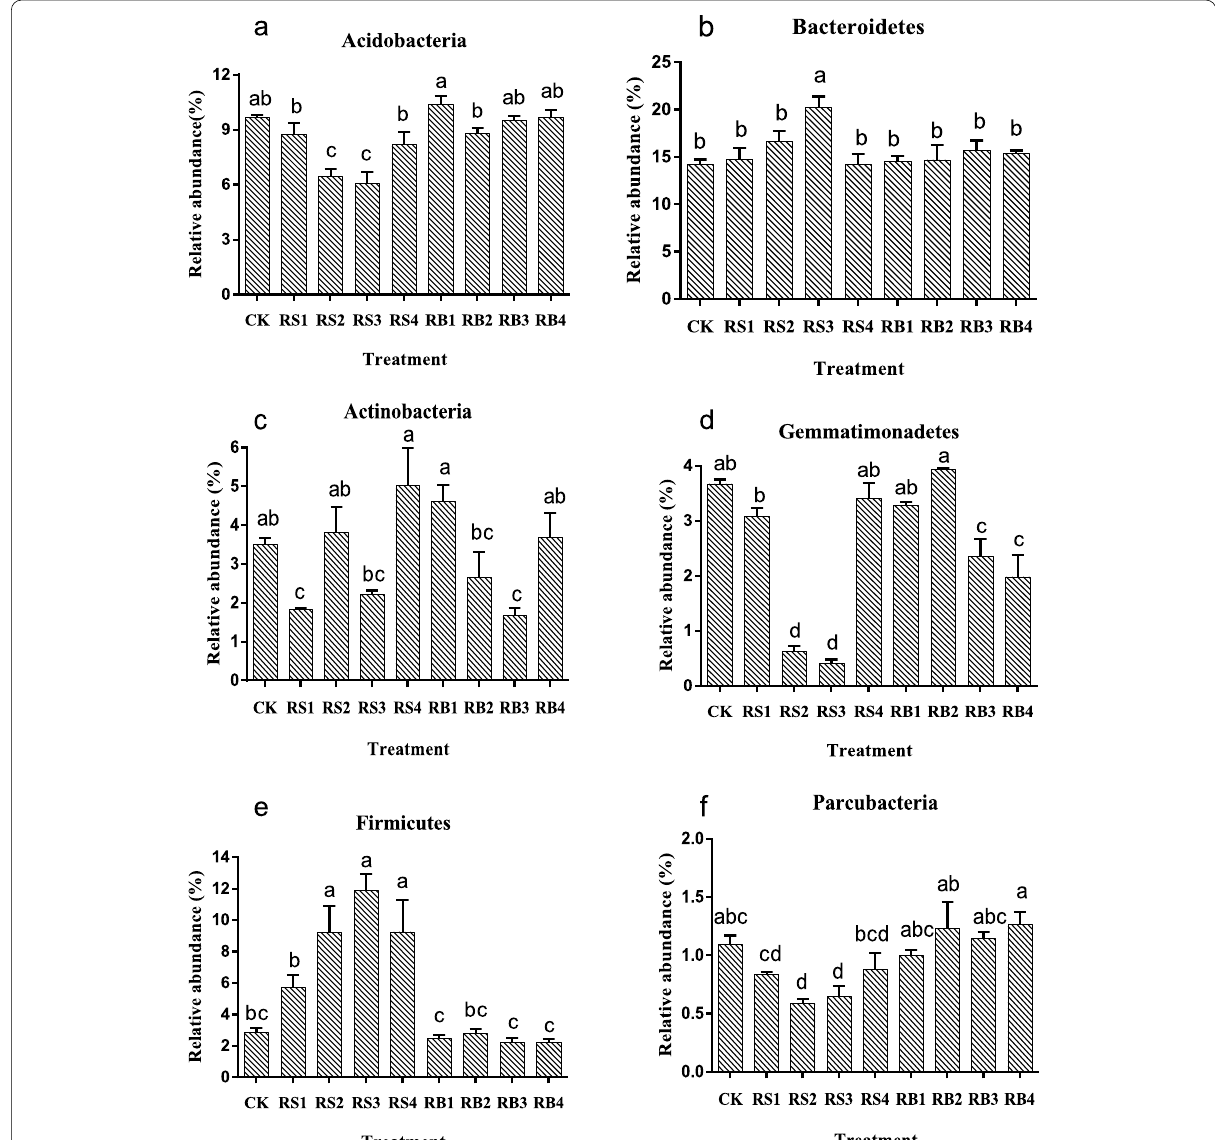
Fig. 1 Effects of different treatments on the relative abundance of bacterial phyla. Different small letters within one column mean significant difference of Duncan multiple range test among different treatments at 5% level. The same as